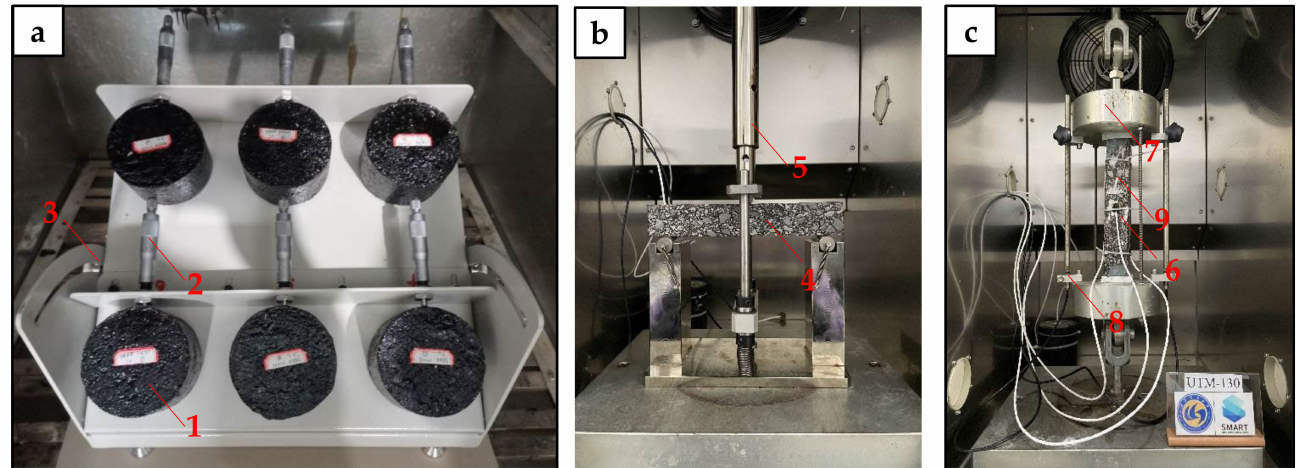
Figure 1. Setups of asphalt concrete slope flow test ( a ), three-point bending (3PB) test ( b ) and thermal stress restrained specimen test (TSRST) ( c ), where: 1—Marshall specimen; 2—Micrometer; 3—Tilt adjustable oblique panel.; 4—3PB specimen; 5—Loading device; 6—Temperature transducer; 7—Cohesive devices; 8—Displacement transducer; 9—TSRST